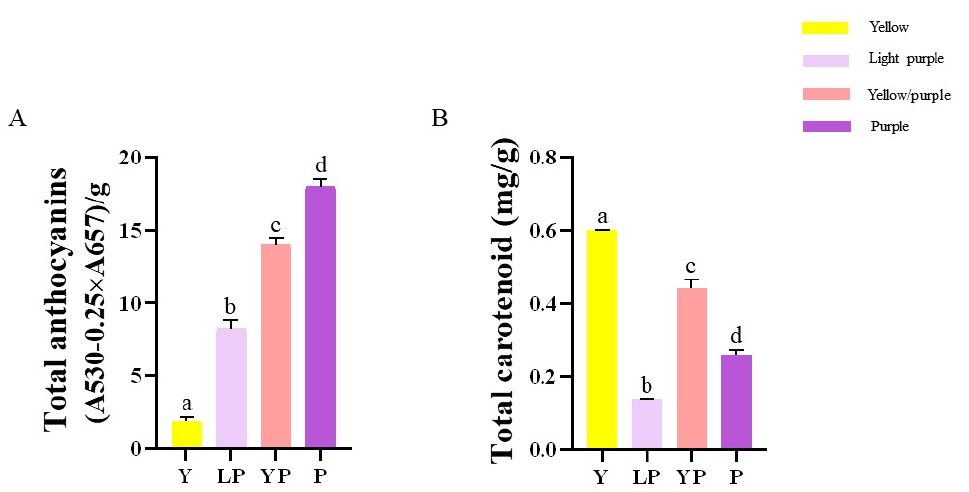
Figure 2. The physiological indicators. ( A ) Anthocyanin extracts in the different petals during the full flowering period. ( B ) Carotenoid extracts in the petals during the full flowering period. Data are means ± SD obtained from three biological replicates. Bars with different letters are significantly different at p < 0.05, according to Tukey’s test.